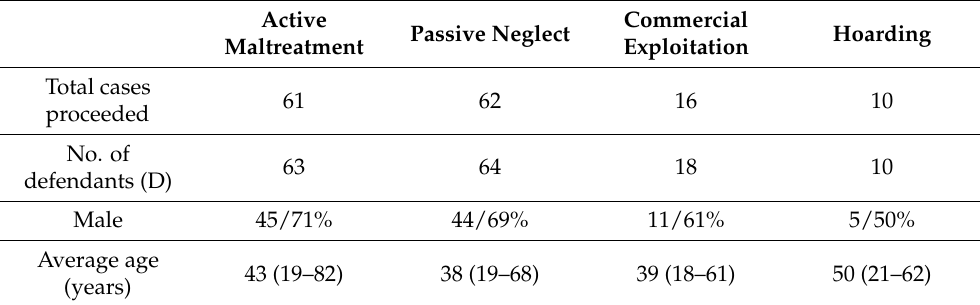
Table 2. Cases and defendant profile by